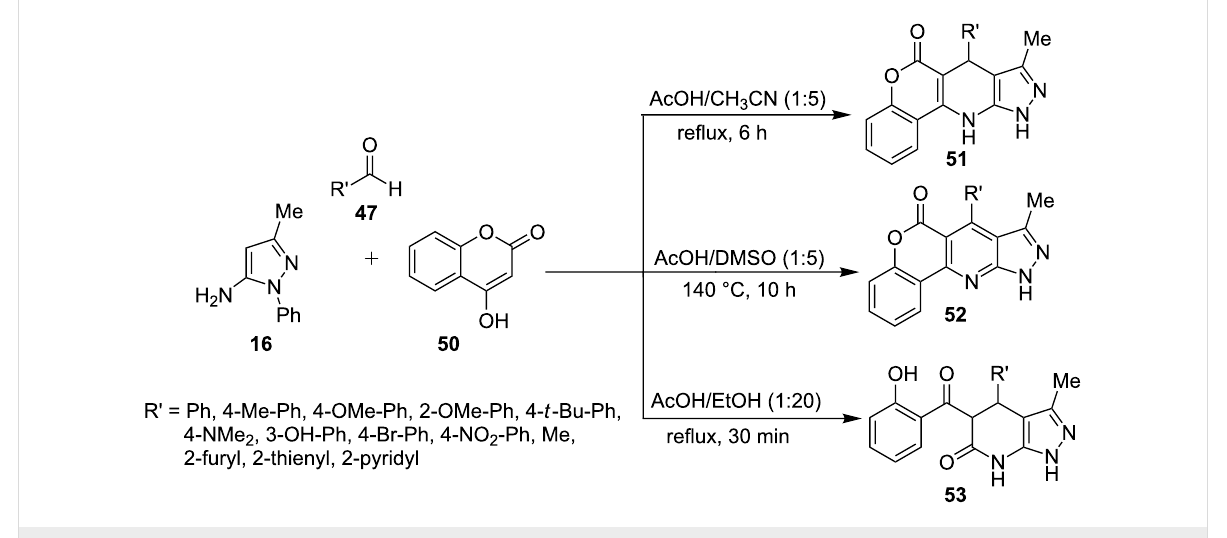
Scheme 10: Three-component synthesis of 4,7-dihydro-1 H -pyrazolo[3,4- b ]pyridine